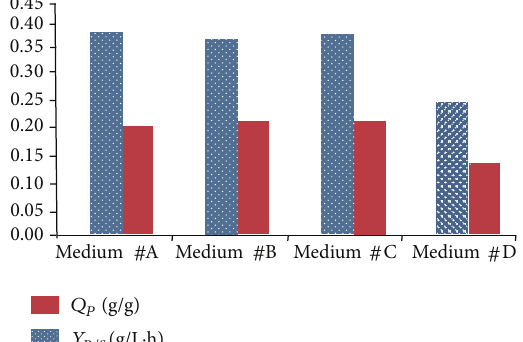
, 𝑄 𝑥 xylose consumption X/S